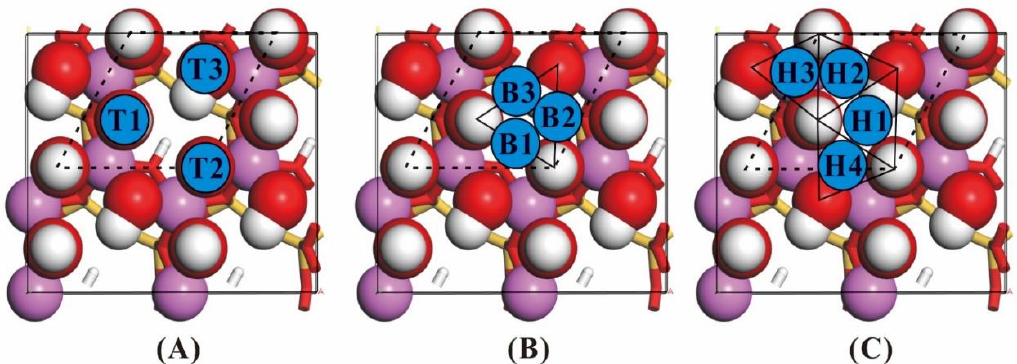
Figure 3. Top view of the kaolinite (001) surface. ( A ) three “Top” adsorption positions (T1-T3); ( B ) three “Bridge” adsorption positions (B1-B3); ( C ) four “Hollow” adsorption positions (H1-H4) (the white ball: H; the red ball: O; the purple ball: Al).